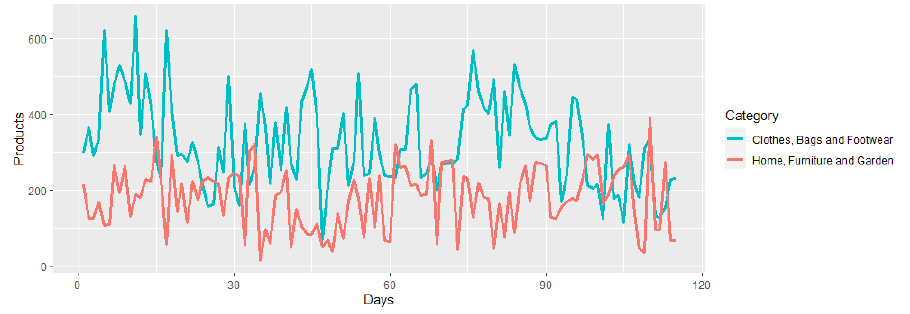
Figure A5. Products per day by category.